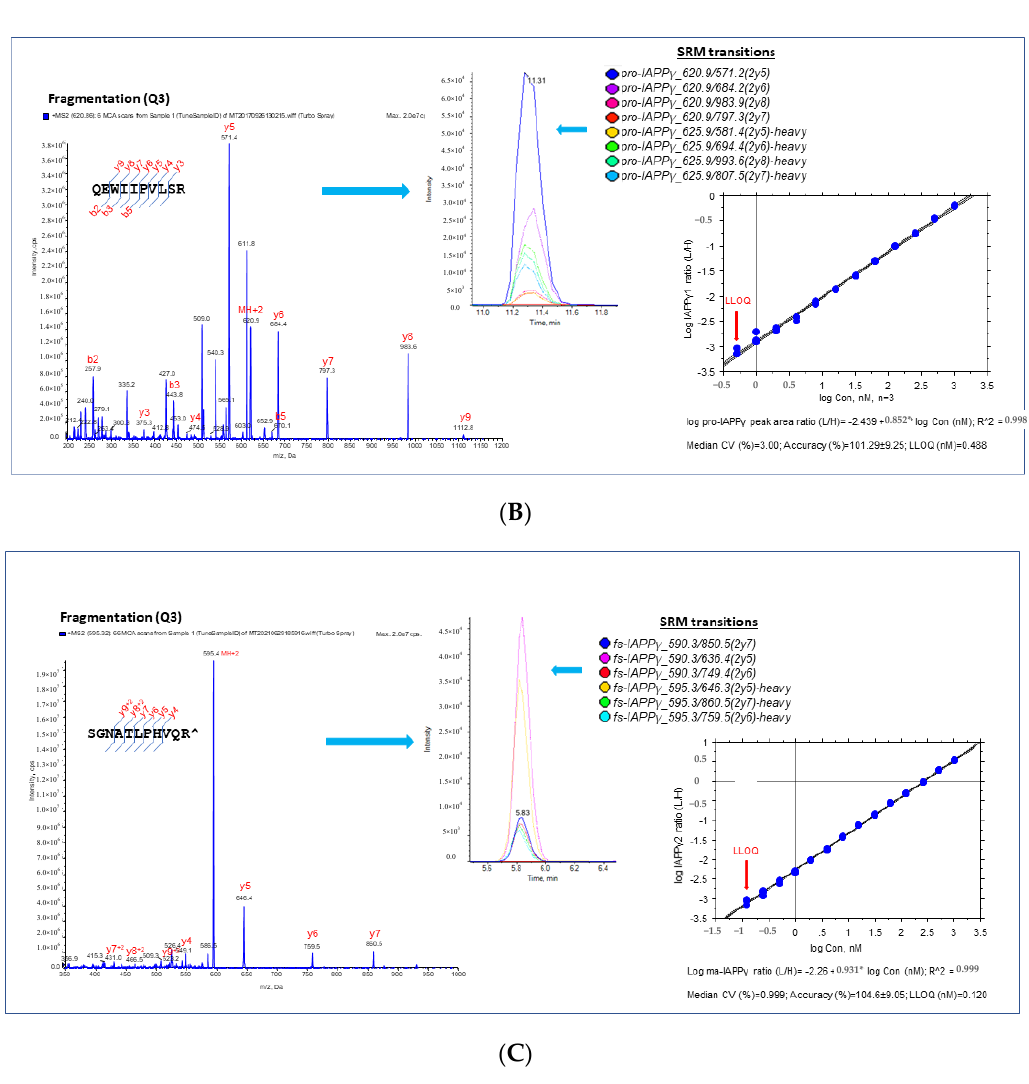
Figure 2. Proteotypic peptides for SRM assay of IAPPs. MS/MS spectra generated by SRM reaction of transitions with light or heavy SIS of target peptides, pro-IAPP β ( A ), pro-IAPP γ ( B ), and fs-IAPP γ ( C ) in the ( left panels ). A set of coeluting peaks in the plasma matrix confirms that the detected SRM signals are derived from each proteotypic peptide in the ( middle panels ). The quantitative validation of the SRM assay is displayed in the ( right panels ). The calibration curve of the SRM assay for each proteotypic peptide in the plasma matrix was carried out as follows: (1) linearity was determined by linear regression between the measured peak area ratio of light and heavy SIS versus the theoretical concentration of light-SIS peptide in the plasma matrix prepared from pooled samples; we display the linear regression with the dashed line representing CI (95%) for the mean, n = 3; (2) accuracy was estimated by back fitting data to the STD curve from all quantified points (>5 points) in the plots, as expressed as the mean ± SD (%); and (3) LLOQ was determined from the standard curve, defined as the lowest concentration with acceptable CV < 20% and accuracy within 100 ± 20%.